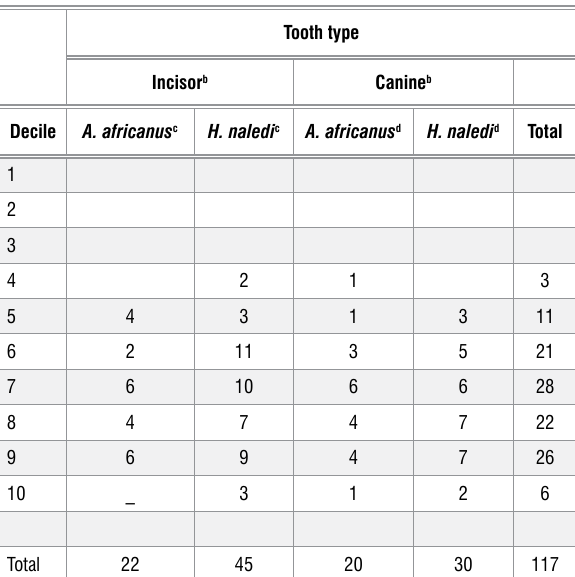
Distribution of counts of linear enamel hypoplasia events along incisor and canine crowns, from apex to cervix in deciles, compared between Australopithecus africanus and Homo naledi a Tooth